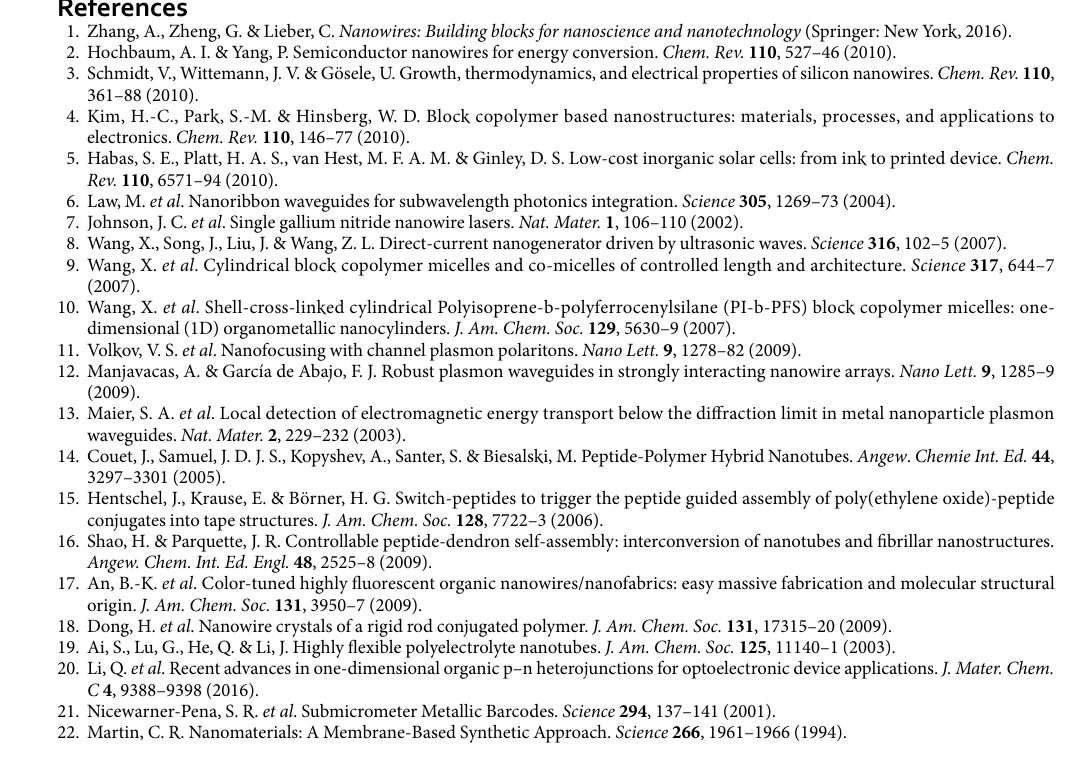
filter was used to exclude most of the inelastically scattered electrons to improve image contrasts (ZLF, zero-loss filtered imaging ). UV absorption spectroscopy . UV-Vis spectra were obtained using a Cary 5000 UV-Vis-NIR spec- trophotometer (Varian Inc.). The Zeta-potential was measured with a Zetasizer Nano ZS (Malvern Instruments Ltd.) at a scattering angle of 173°.